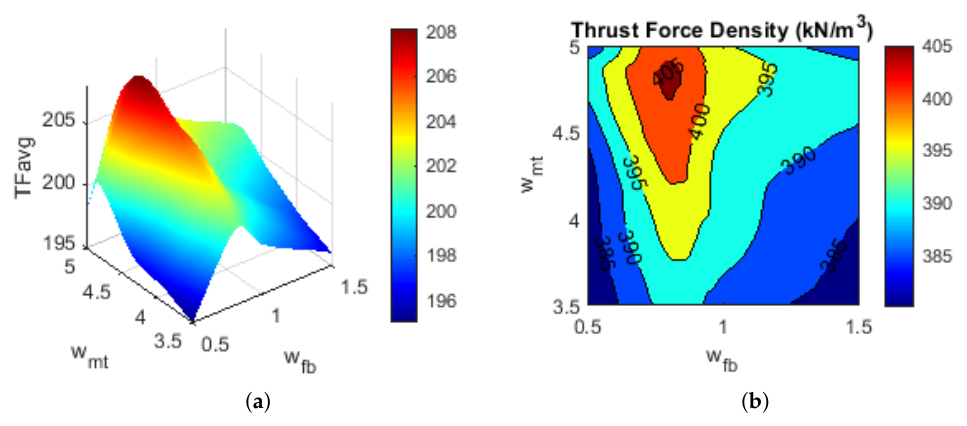
Figure 10. Influence of w fb and w mt on ( a ) TF avg ( b ) TFD .